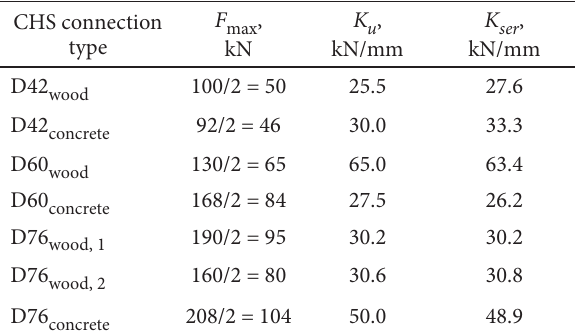
Table 1. Performance parameters established for a single CHS connector CHS connection type